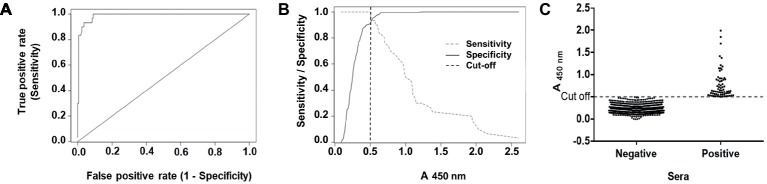
ROC curve, sensitivity and specificity graph of the in-house ELISA, and seroprevalence of anti-HEV IgG antibodies in blood donors. (A) ROC curve obtained with 197 characterized sera for their reactivity to HEV. (B) The cut-off value of the assay (A450nm values = 0.498) as determined by the optimal values of the sensitivity (dashed gray line) and specificity (full black line) curves. (C) Prevalence of anti-HEV antibodies in 813 blood donors. Results are depicted as absorbance values at λ = 450 nm. Samples with A450nm values > 0.498 were considered as positive using the optimal parameters determined before for the ELISA.